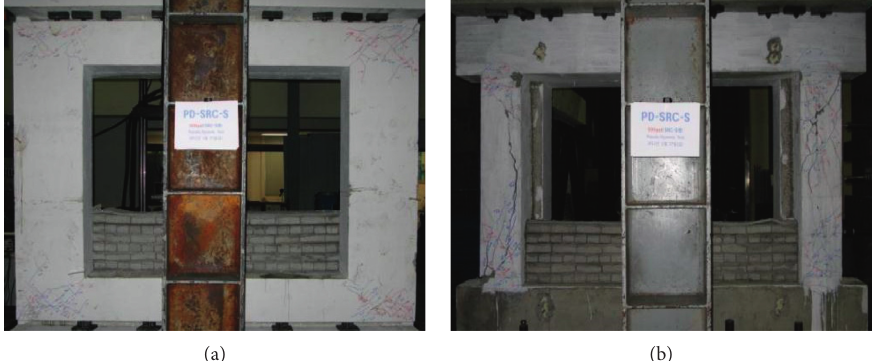
Figure 27: Cracks appeared in the PD-BESRCF specimen during pseudodynamic testing at 450gal after (a) 1.5 s with lateral displacement of 13.5mm and force of –372kN, and (b) during the final stage